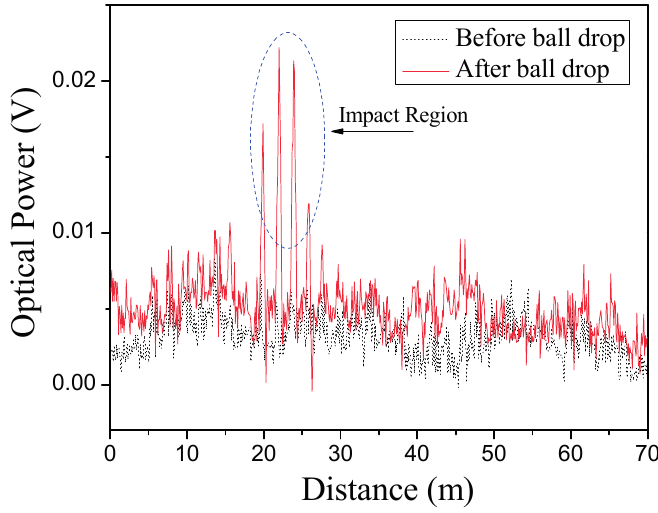
Figure 4. Static data along the fiber distance (11.20 GHz).